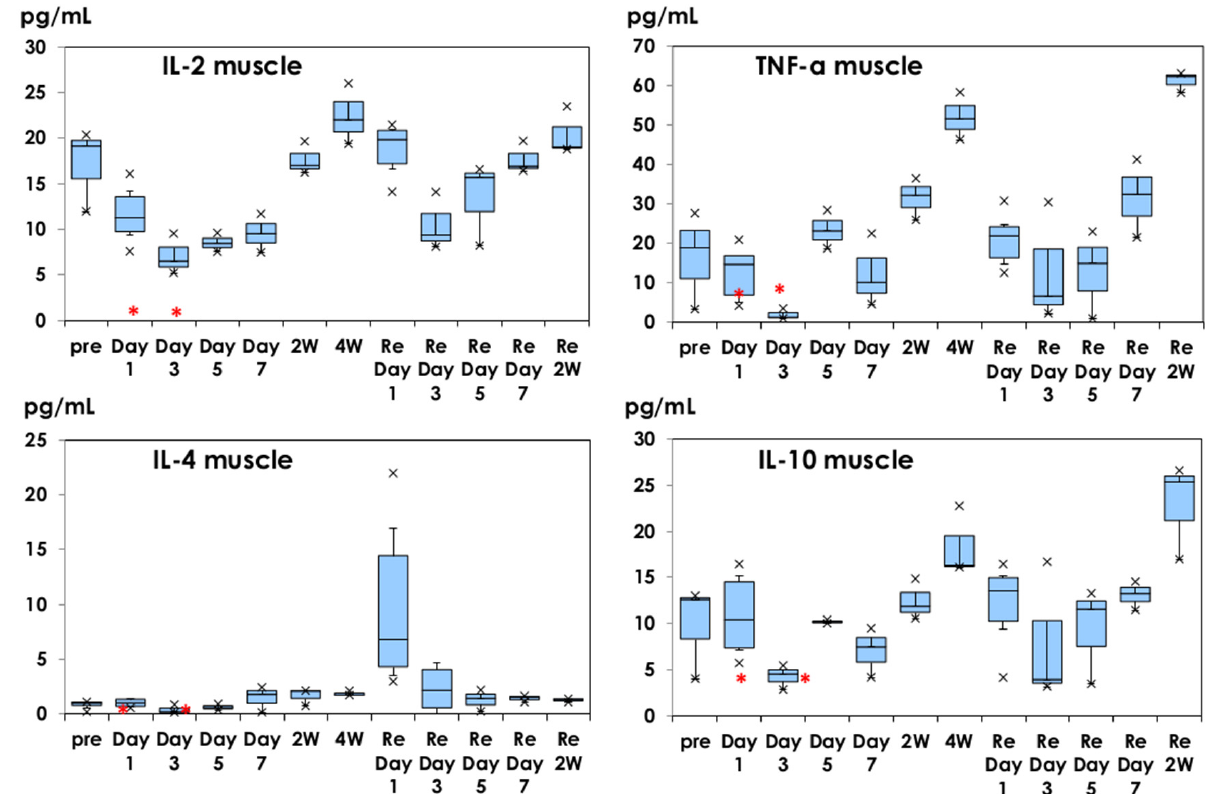
Figure 4. IL-2, IL-4, TNF- α , and IL-10 production in muscle tissues. They are shown in box-and- whisker plots with a median titer and the range of 5–95%. Samples were obtained before injection, on days 1, 3, 5, and 7, and at 2 and 4 weeks after the first dose. The second dose was administered at 4 weeks and samples were obtained based on the same schedule. *: mean concentration of five mice as a control on day 1 of physiological saline injection. ×: outliers.